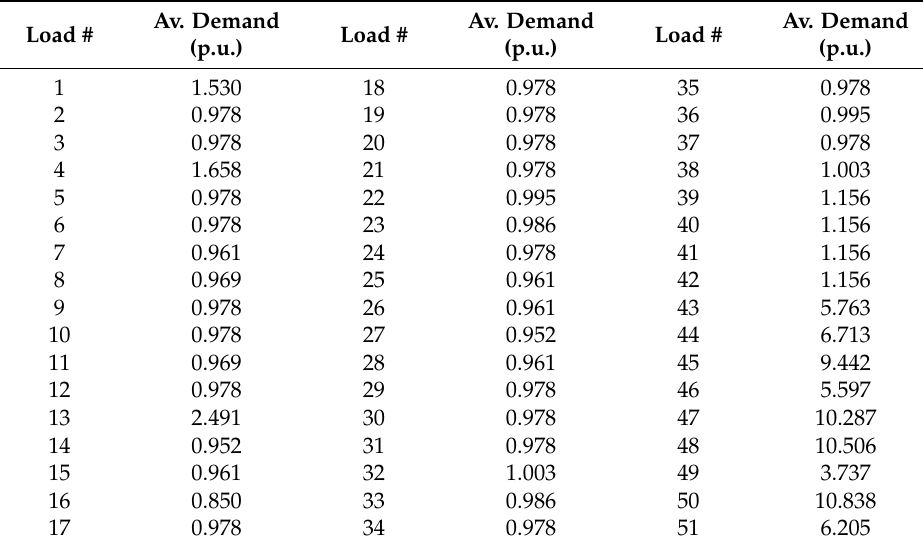
Figure 7. Reduced low voltage (LV) feeder system, adapted from reference [10]. Table 4. Test system average demand per load, per user (p.u.)